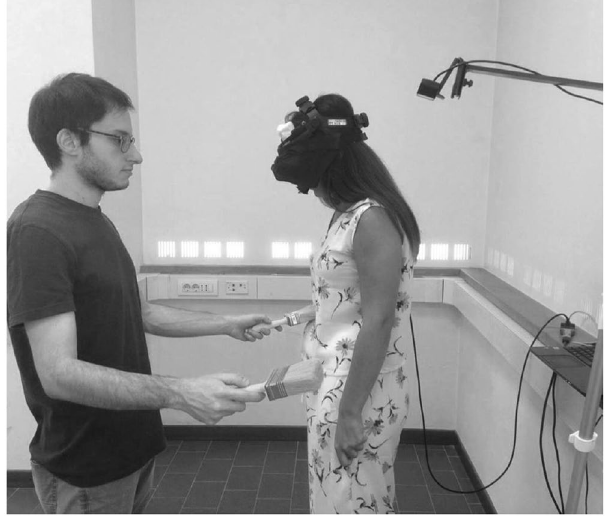
Figure 1. Experimental setup of the invisible body illusion. Participants watched in the HMDs the empty space captured by the camera. To induce the illusion, the experimenter applied touches to the participant’s body with a paintbrush and moved another paintbrush in the empty space in corresponding position.